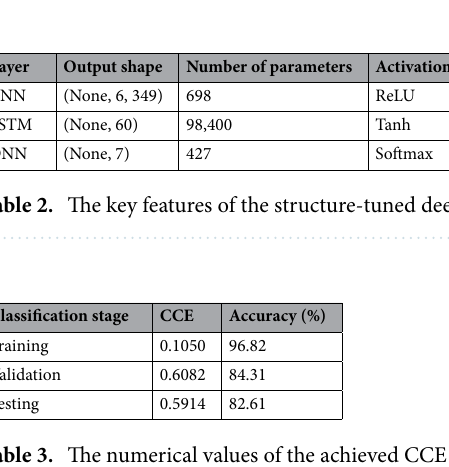
Table 3. The numerical values of the achieved CCE and accuracy by the developed